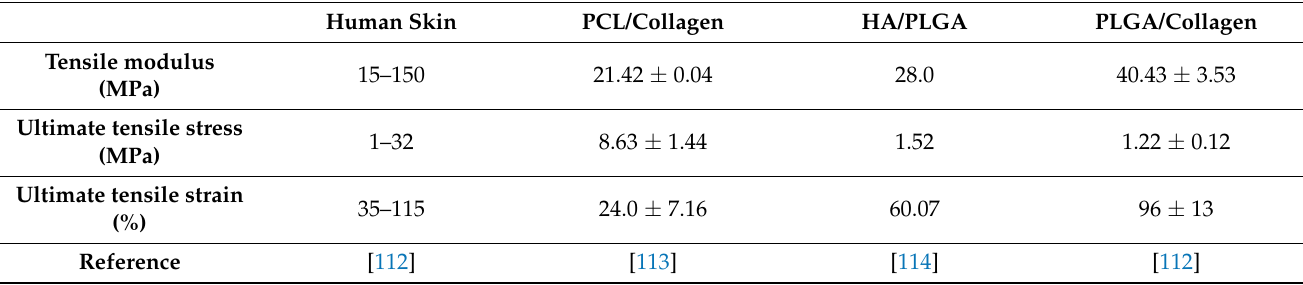
Table 3. Nanofibers mimic the mechanical properties of the human skin with a